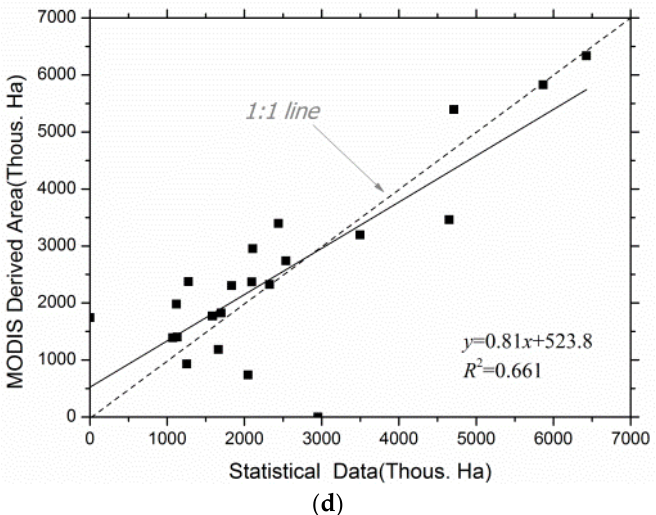
Figure 8. Comparison between extraction results and the statistical data: ( a ) comparison of statistical data and MODIS-derived rice areas for the 63 provinces in Vietnam; ( b ) comparison of planted areas of less than 500 km 2 for a total of 22 provinces using statistical data with the MODIS-derived rice areas; ( c ) comparison of statistical data of planted areas from 500 km 2 to 1000 km 2 for a total of 18 provinces and MODIS-derived rice areas; ( d ) comparison of statistical data of planted areas from 1000 km 2 to 7000 km 2 for a total of 23 provinces and MODIS-derived rice areas.